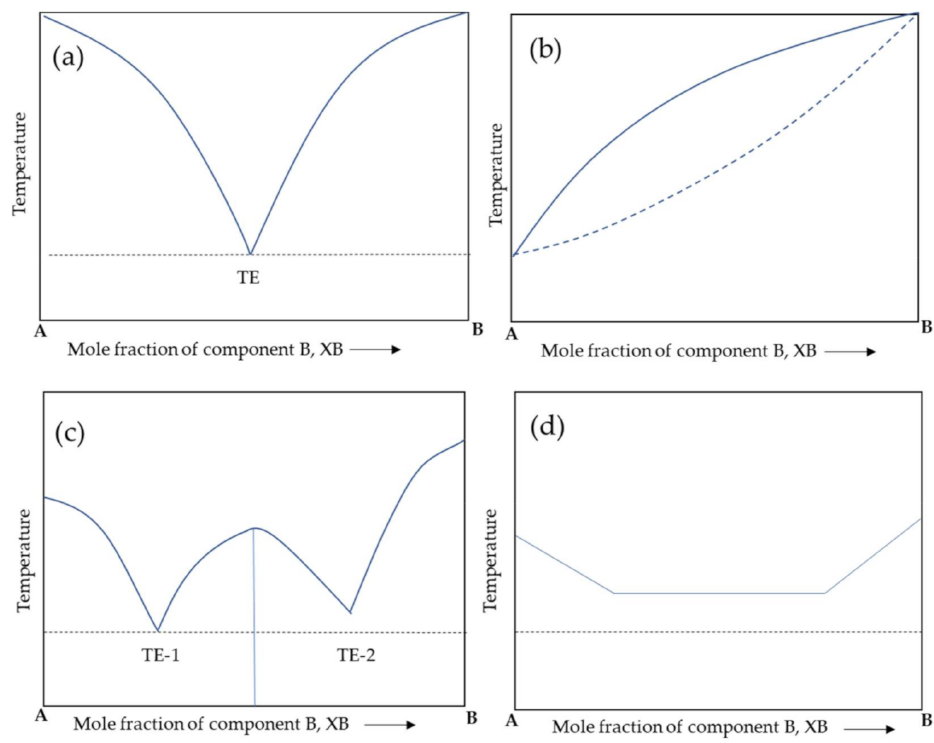
Figure 4. Schematic representation of binary phase diagrams for eutectic formation ( a ), solid solution formation ( b ), co-crystal formation ( c ), and physical mixture (dotted line—onset of first compo- nent melting; dark line—melting of the second component) ( d ). (Reproduced from [7]). Note: TE = temperature of eutectic